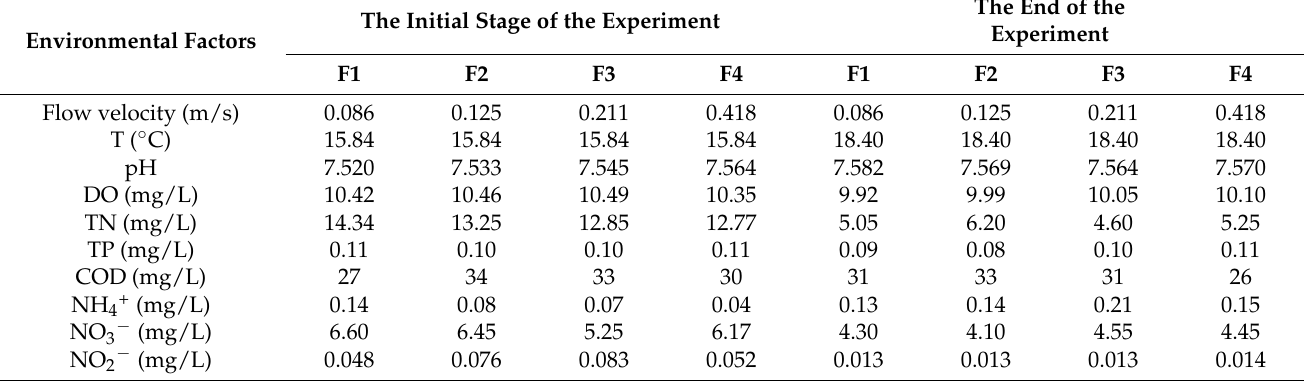
Table 1. Statistics of water environment indicators under gradient flow velocity before and after the experiment.